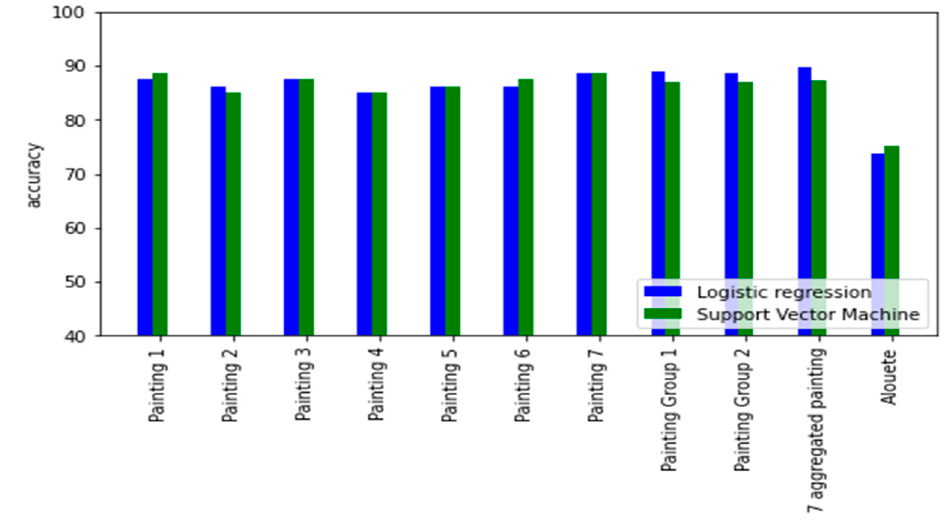
Figure 5. Pair plot of the accuracy of the support vector machine and the logistic regression when using DGI based feature on analysis 1, 2 and 3.